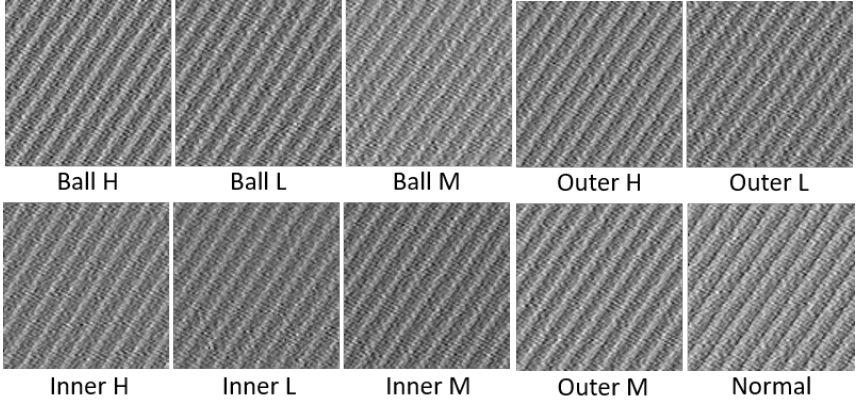
Figure 8. Data samples with 2000 rpm in speed and 10 V in brake voltage of FSTB Direction X. “H” indicates “Heavy”, “L” indicates “Light”, and “M” indicates “Moderate”, which represent different fault degrees. “Outer”, “Inner”, and “Ball” represent different fault position, respectively. “Normal” indicates no fault.